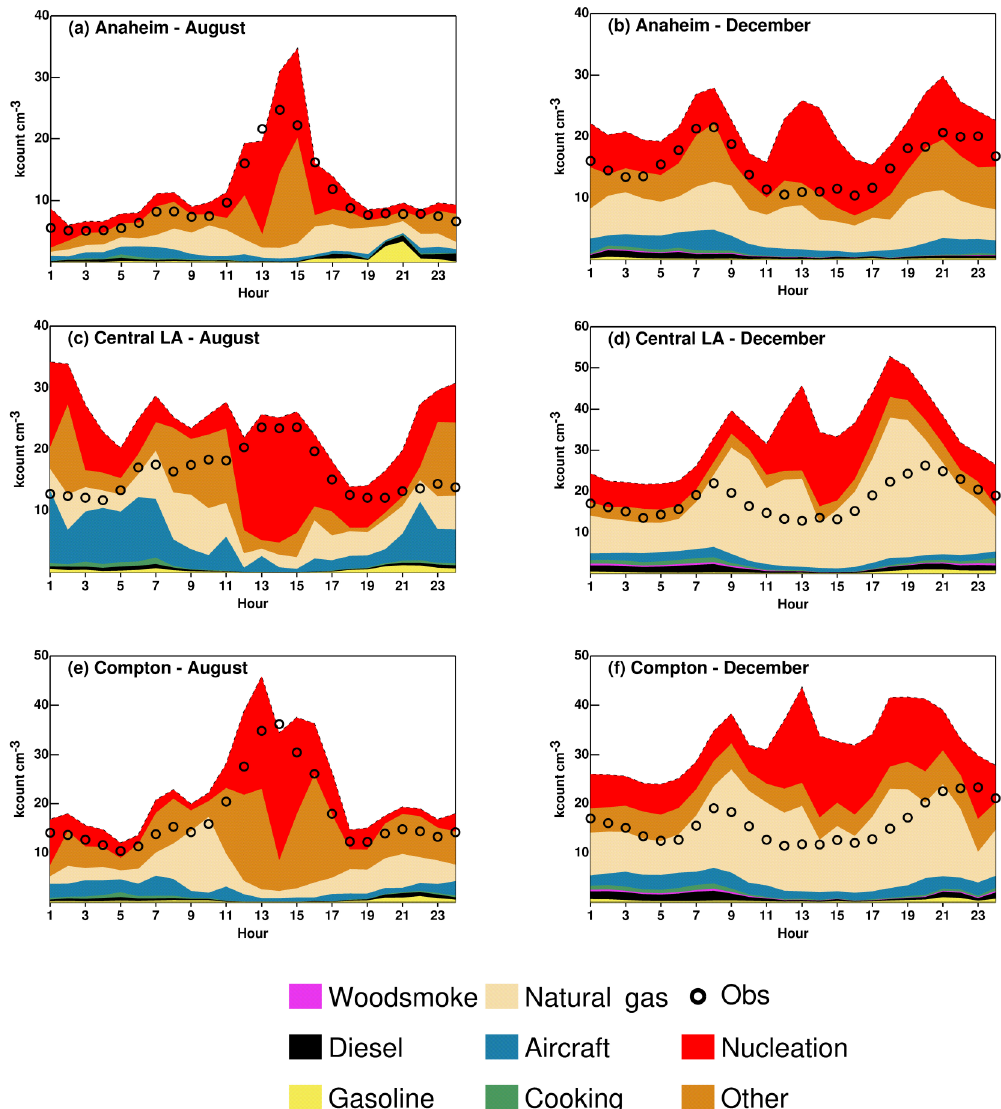
Figure 16. Diurnal variations of measured N 7 and predicted best-fit N 10 averaged for August 2012 (a, c, e) and December 2012 (b, d, f) at Anaheim, central LA, and